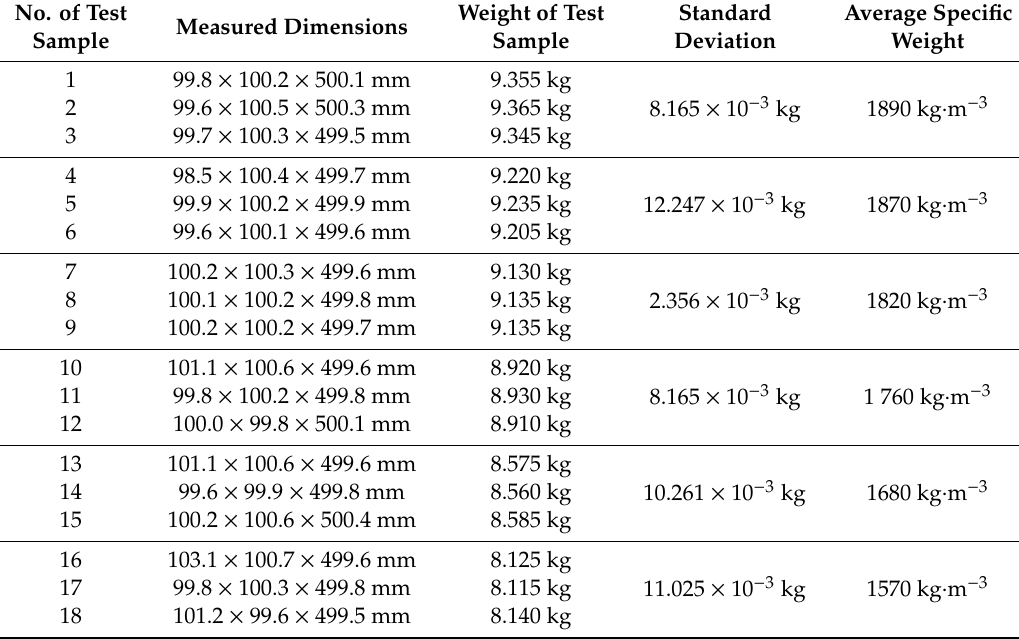
Table 3. Measured dimensions, weight, and average specific weight of the test